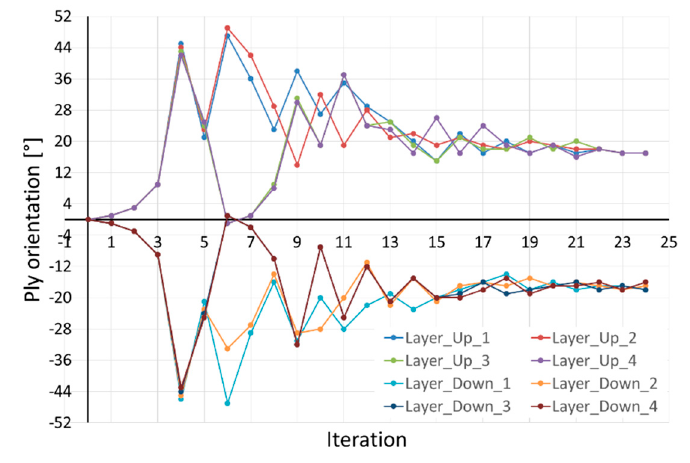
Figure 12. Graph with the angles ply iterative process.